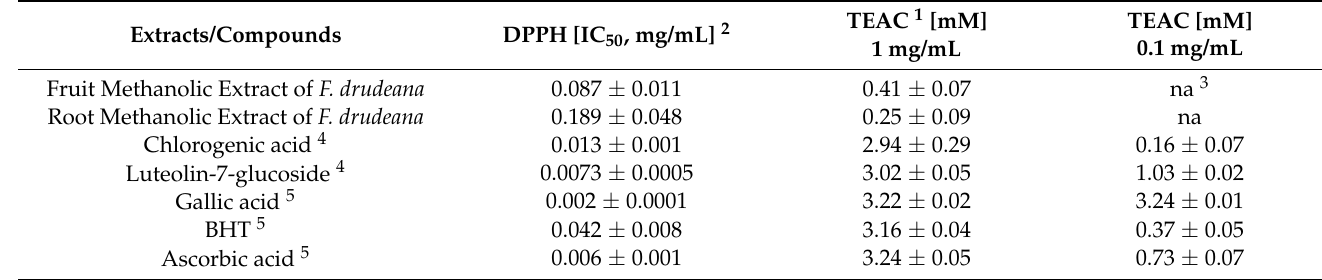
Table 5. Antioxidant activities of Ferula drudeana extracts and standards.